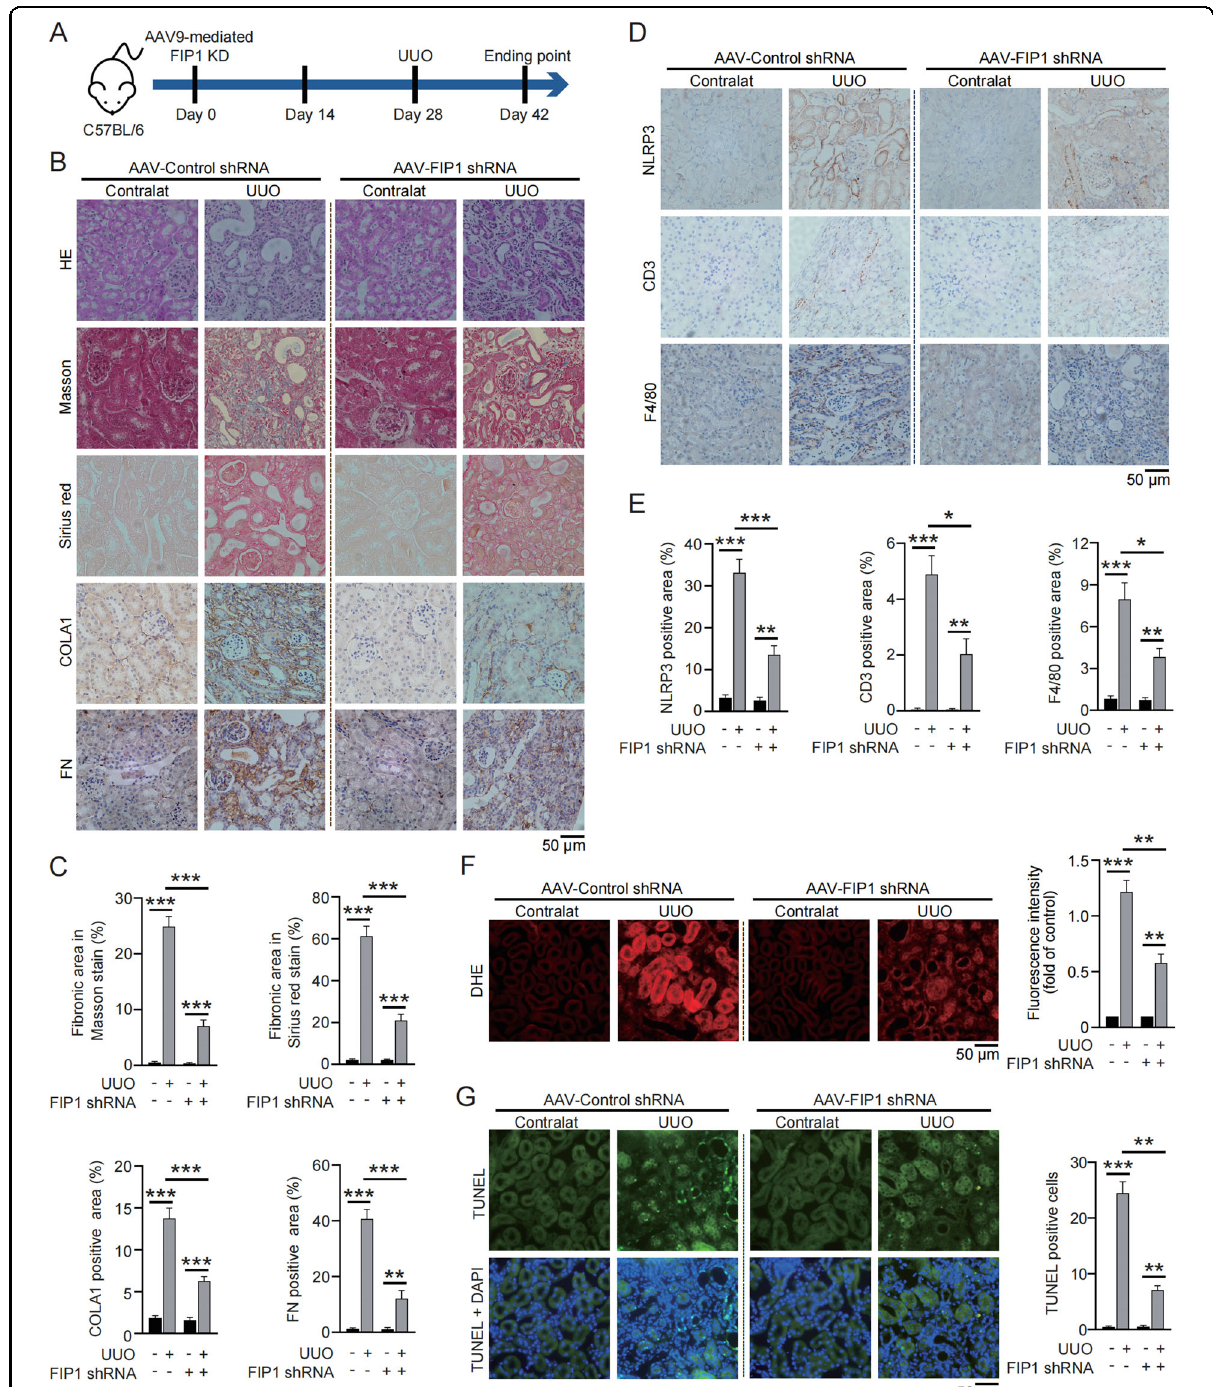
Fig. 7 FIP1 KD alleviates UUO-induced fi brogenesis, in fl ammation activation, oxidative stress, and apoptosis. A Schematic diagram demonstrating the animal experiment design. B The representative of HE staining, Masson ’ s trichrome staining, Picrosirius Red staining, and IHC staining for collagen I and fi bronectin in kidney specimens from the indicated group of mice ( n = 5 per group). C Quantitative analysis of Masson ’ s trichrome staining, Picrosirius Red staining, and IHC staining for collagen I and fi bronectin in kidney specimens from the indicated group of mice. D The representative of IHC staining for NLRP3, CD3, and F4/80 in kidney specimens from the indicated group of mice. E Quantitative analysis of IHC staining for NLRP3, CD3, and F4/80 in kidney specimens from the indicated group of mice. F Representative images and quantitative analysis of DHE in kidney specimens from the indicated group of mice. G Representative images and quantitative analysis of TUNEL staining in kidney specimens from the indicated group of mice. * P <0.05; ** P <0.01; *** P <0.001; All data represent the mean±SEM obtained from three independent experiments. Student ’ s t